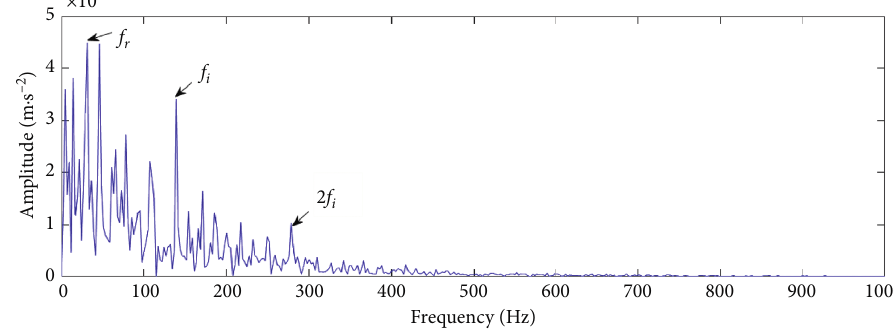
Figure 14: Envelope spectrum of sensitive IMF component.